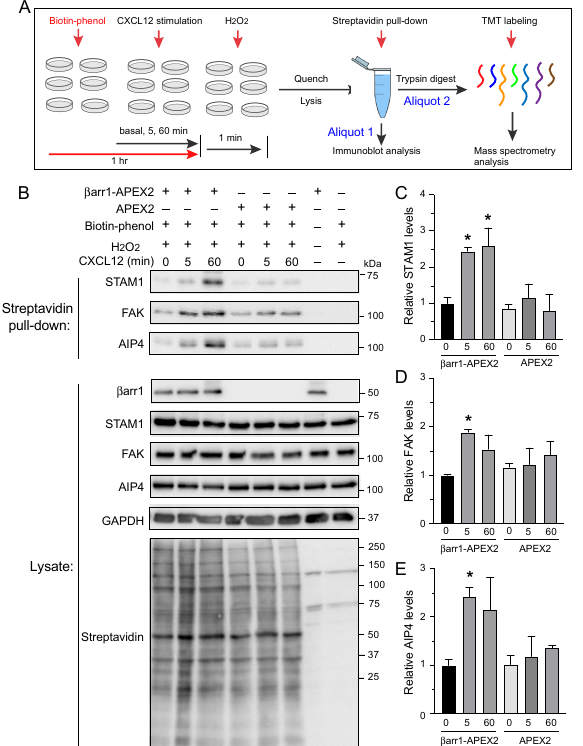
Figure 3. Proximity labeling and experimental workflow for identifying the β arr1 interactome. ( A ) Schematic representation of proximity labeling and experimental workflow. HeLa cells transiently transfected with β arr1-APEX2, APEX2, or empty vector (pcDNA3) were preincubated with biotin- phenol for 1 h. During this time, CXCL12 was added to cells to stimulate endogenous CXCR4 for 5 min or 60 min or not added (basal). Proximity labeling was completed upon hydrogen peroxide treatment for 1 min. After quenching and harvesting, cleared cell lysates were divided into two aliquots. Aliquot 1 was analyzed by streptavidin affinity purification and immunoblotting or while Aliquot 2 was snap-frozen and stored at − 80 °C and analyzed by mass spectrometry later. Briefly, aliquot 2 from three biological replicates were processed simultaneously by streptavidin affinity purification, trypsin digestion and tandem mass tag (TMT) labeling for mass spectrometry analysis. ( B ) Immunoblot analysis of proximity-labeled proteins known to interact with β arr1 during the time course of stimulation with CXCL12. Shown are representative immunoblots from one of three independent experiments. ( C – E ) STAM1 ( C ) FAK ( D ), and AIP4 ( E ) immunoblots were analyzed by densitometry. Bars represent the mean from three independent experiments normalized to the basal condition (zero). The error bars represent S.D. Data were analyzed by one-way ANOVA followed by Bonferroni’s multiple comparison test. Asterisk (*) indicates adjusted p value < 0.05 relative to the basal condition.